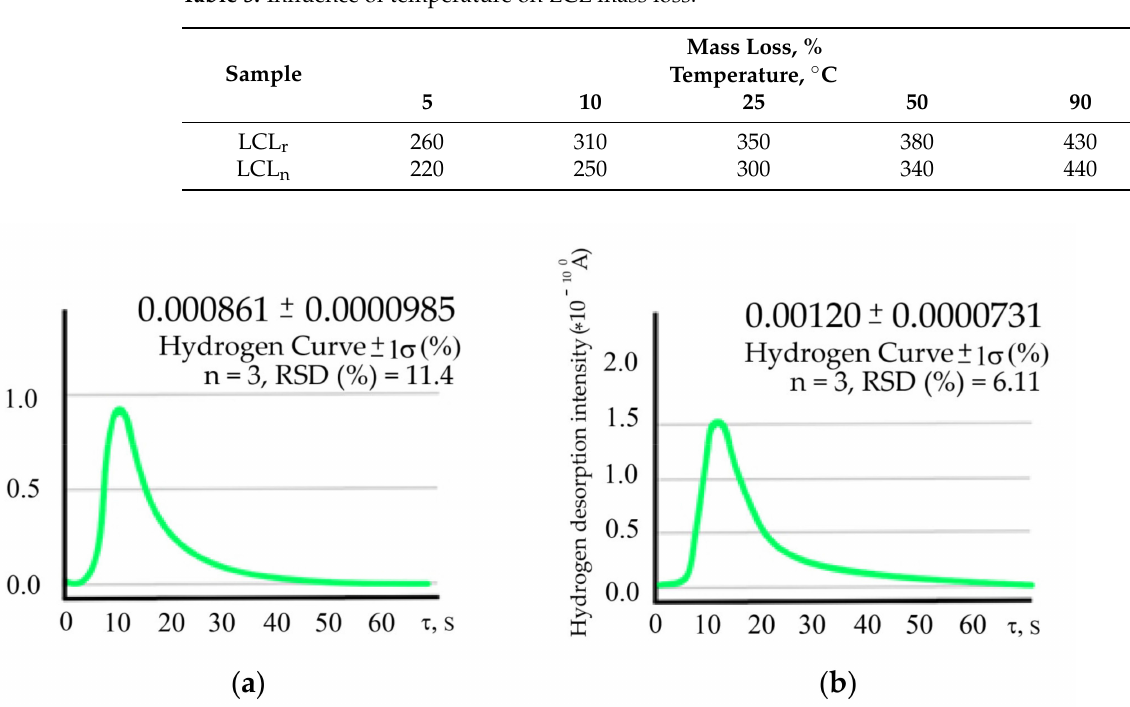
Figure 9. Changing of hydrogen desorption intensity (tigel current, A) from the the nitrogen steel chips after surface treatment in: Water ( a ); LCL n ( b